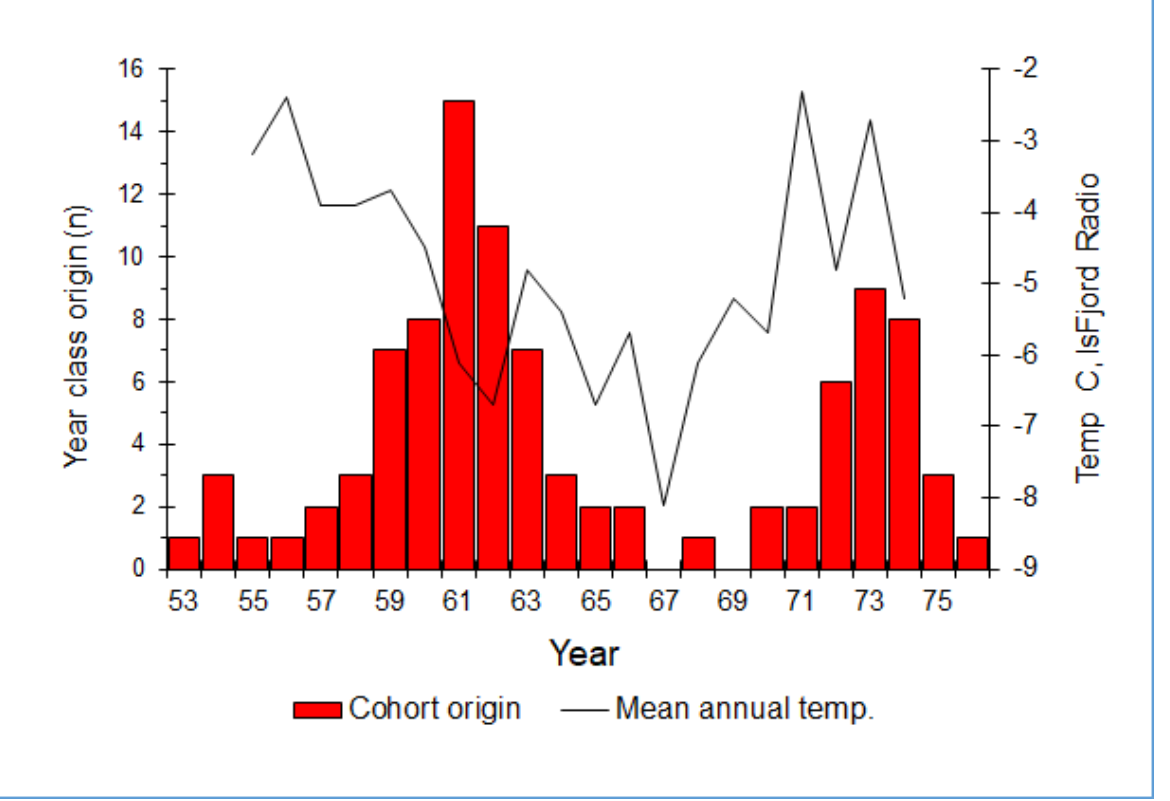
Figure 2. Year-class strength, shown as pooled numbers of all sampled landlocked char born in specific years, and the corresponding mean annual air temperature recorded at Isfjord Radio weather station.